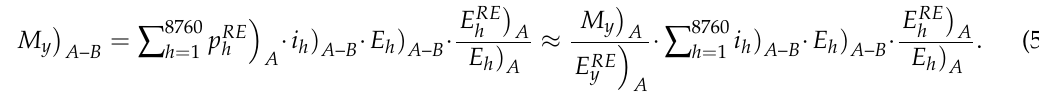
( c ) Figure 5. 2015–2017. ( a ) Annual percentages of international SP-FR energy exchanges; ( b ) annual percentages of international SP-PT energy exchanges; ( c ) annual percentages of international SP-MA energy exchanges.